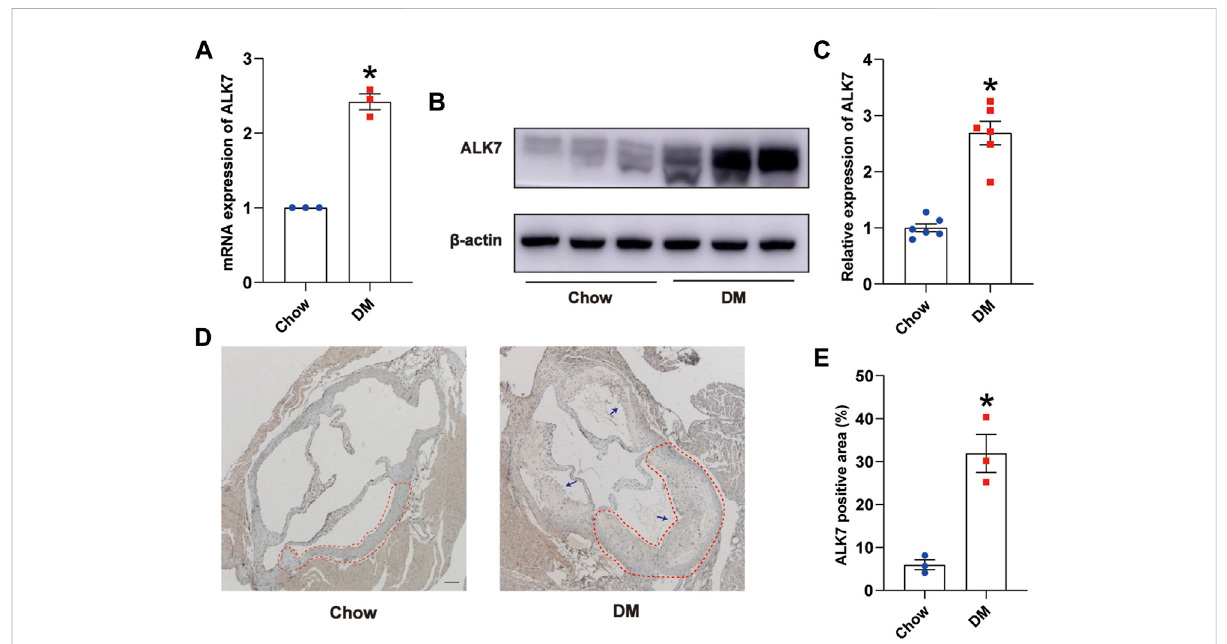
FIGURE 1 ALK7wasincreasedintheaortaswithatheroscleroticlesionsofdiabeticmice. (A) .RelativemRNAlevelofALK7intheaortaswithatherosclerotic plaques of diabetic mice was determined by quantitative real-time PCR. n = 3 per group. (B – C) . Relative protein level of ALK7 in the aortas with atherosclerotic plaques of diabetic mice was determined by western blot. n = 6 per group. (D – E) . Immunohistochemical staining of ALK7 was examined in the aortic root and quanti fi ed. n = 3 per group. Scale bar: 100 μ m. Dashed lines encircled some part of atherosclerotic plaque. Arrows indicated all the atherosclerotic plaques in the aortic root. Data was analyzed with student ’ s t -test. * p < 0.05 vs. the Chow